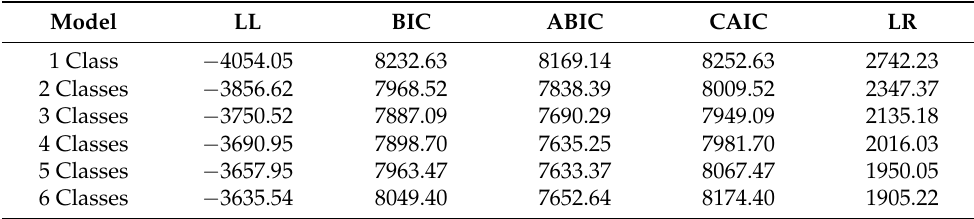
Table 2. Latent class profile solutions and fit indices.